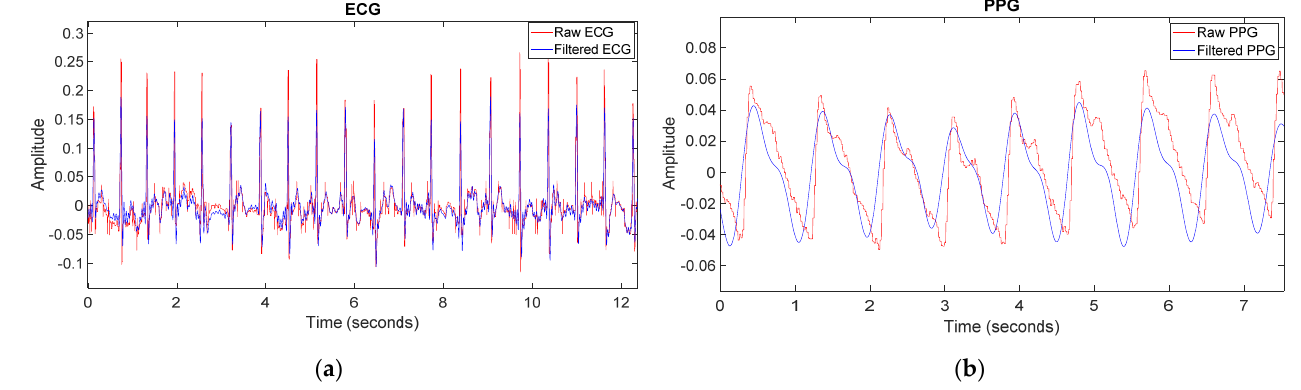
Figure 8. ( a ) Raw ECG signal in red and the filtered signal in blue; ( b ) Raw PPG signal in red and the filtered signal in blue.